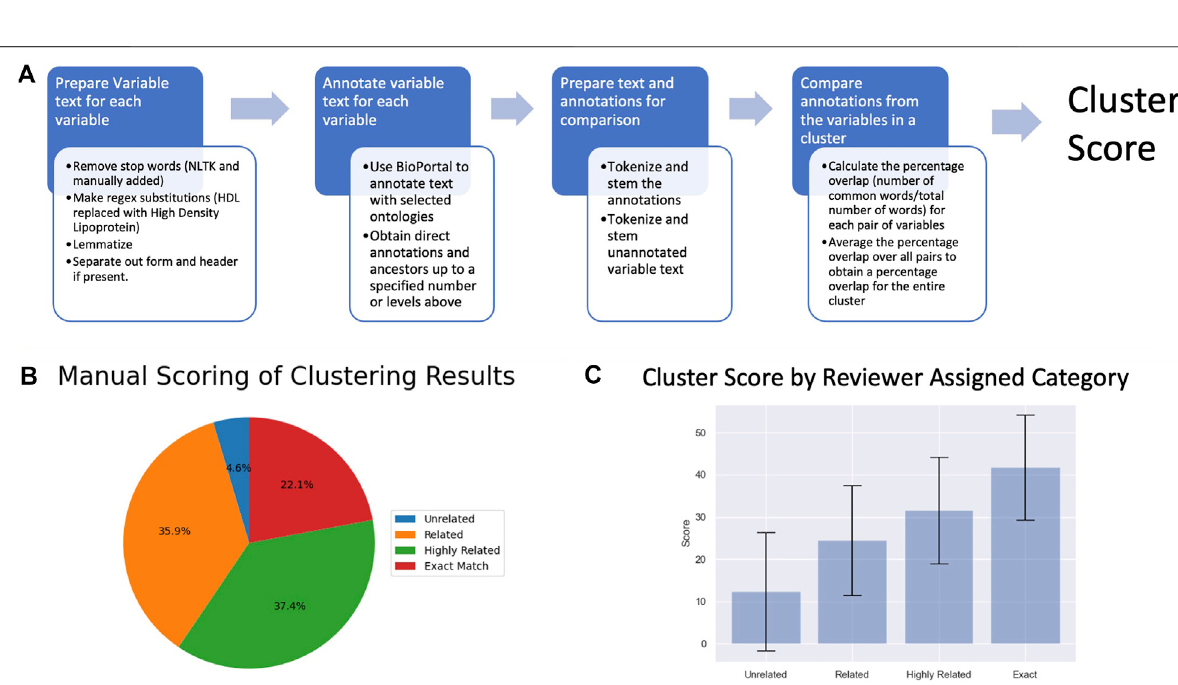
( Figure 3 ). The manual evaluation process involved human